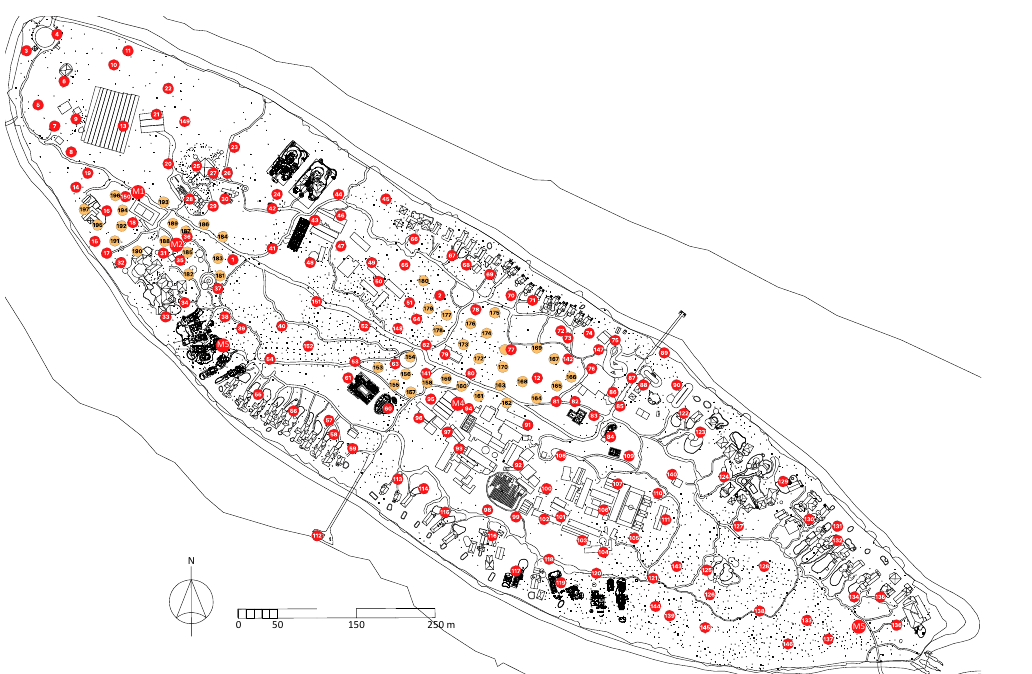
Figure 2. BG-MosquitaireCO2 trap locations on Kunfunadhoo island. Red numbered traps (150) were deployed in June 2019. Orange numbered traps (45) were deployed in October 2019 and M1-M5 (groups of 11 traps each; 55 in total) in March 2020, giving a total of 250 traps. For every numbered trap shown in red, 2 BG-GAT traps were deployed in their immediate vicinity (300 in total), in June 2019. Black dots on the map depict palm trees ( Cocos nucifera L.).